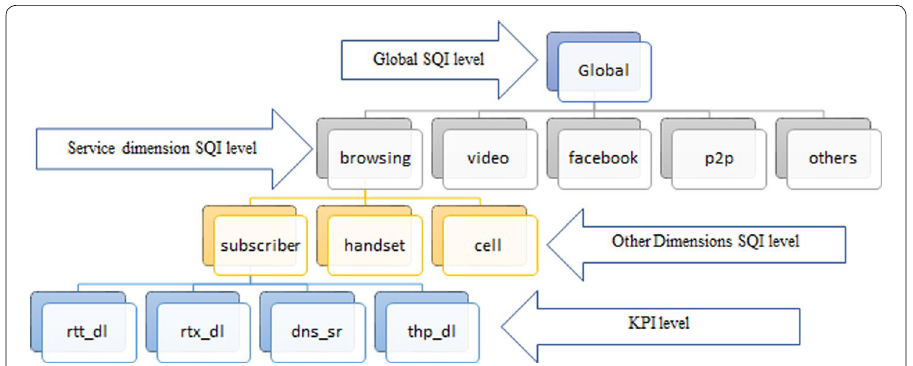
Fig. 2 Proposed SQM-tree approach: The proposed SQM tree has four levels. The Global level which is the most aggregated SQI, followed by the service level divided into four main services categories and others. The 3rd level consists of the remaining dimensions which are the subscriber, the handset and the cell. Finally, the 4th level holds the values of the four selected